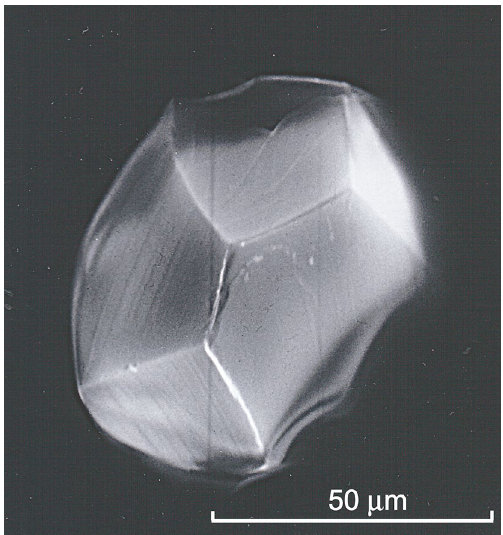
Figure 2. Scanning electron microscope image of a synthesized Al-phase D single-crystal. As an example, that of the run #3 is given